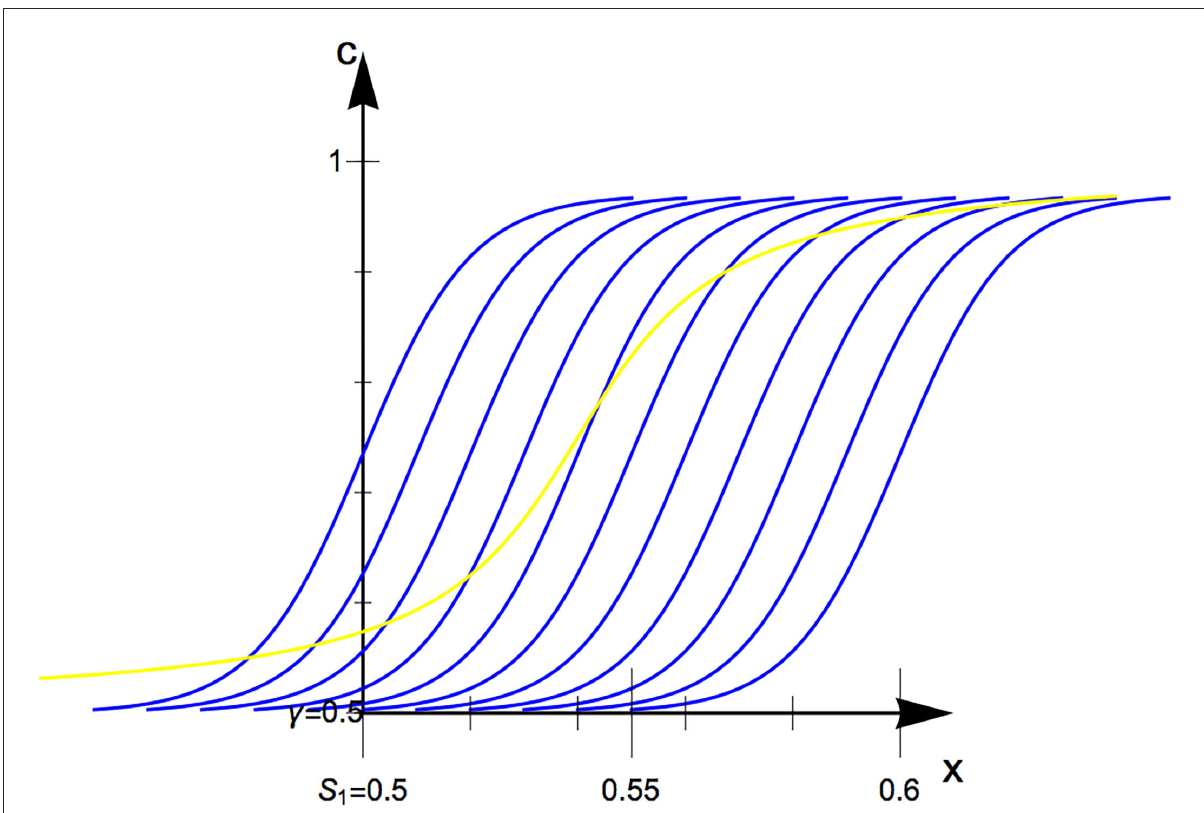
FIGURE3 Six exemplary hypotheses (blue) and the actual psychometric function (yellow). Even though the slope is different, H 3 approximates the just noticeable difference (JND)